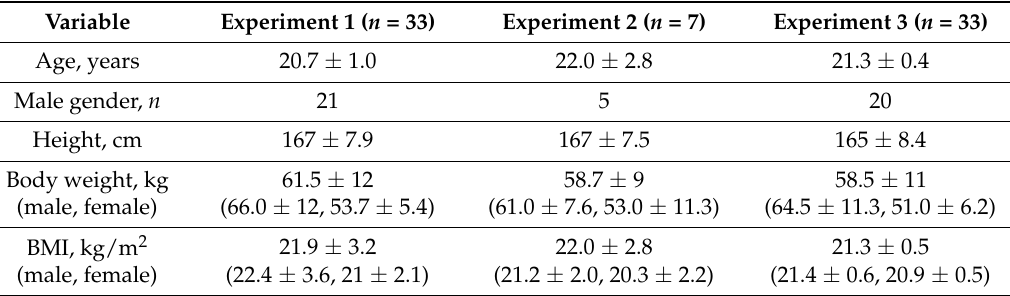
Table 1. Characteristics of the